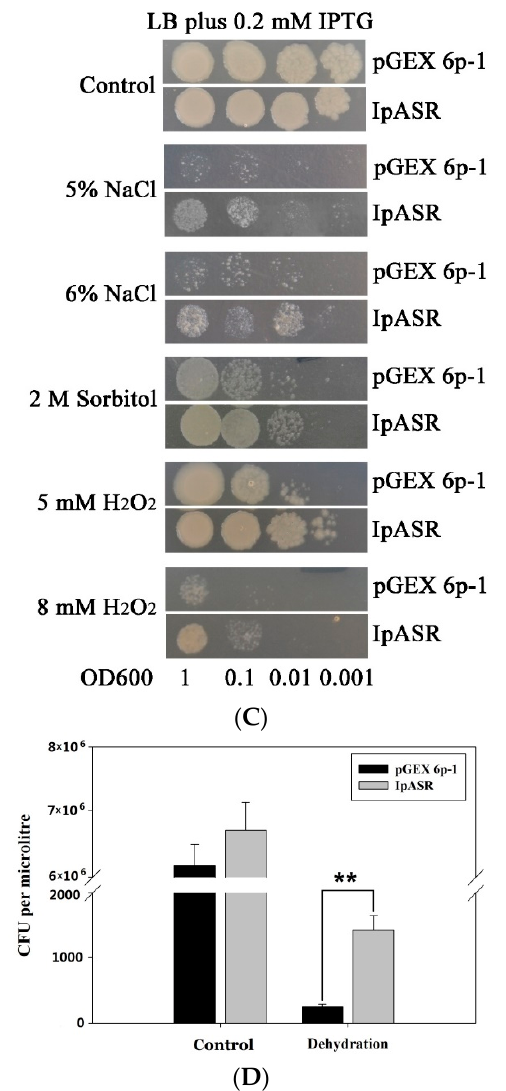
Figure 4. Functional analysis of IpASR induced-expression for salt, drought, and H 2 O 2 tolerance in E. coli . ( A ) Induced expression of the GST-IpASR (IpASR-pGEX 6p-1) fusion protein and single GST (pGEX 6p-1 empty vector) protein in E. coli . 0 and 4 h: The respective IPTG